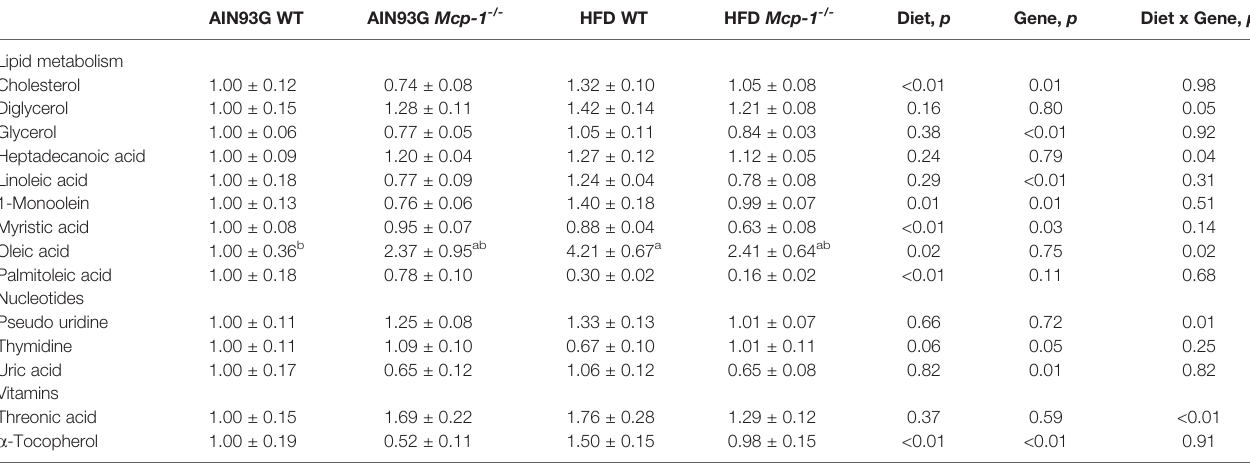
TABLE 4 | Identi fi ed plasma metabolites related to lipid, nucleotide, and vitamin metabolisms that differed in MMTV-PyMT mice with or without adipose monocyte chemotactic protein-1 knockout [ Mcp-1 -/- or wild-type (WT)] and fed the AIN93G or high-fat diet (HFD). AIN93G WT AIN93G Mcp-1 -/- HFD WT HFD Mcp-1 -/- Diet, p Gene, p Diet x Gene, p Lipid metabolism Cholesterol